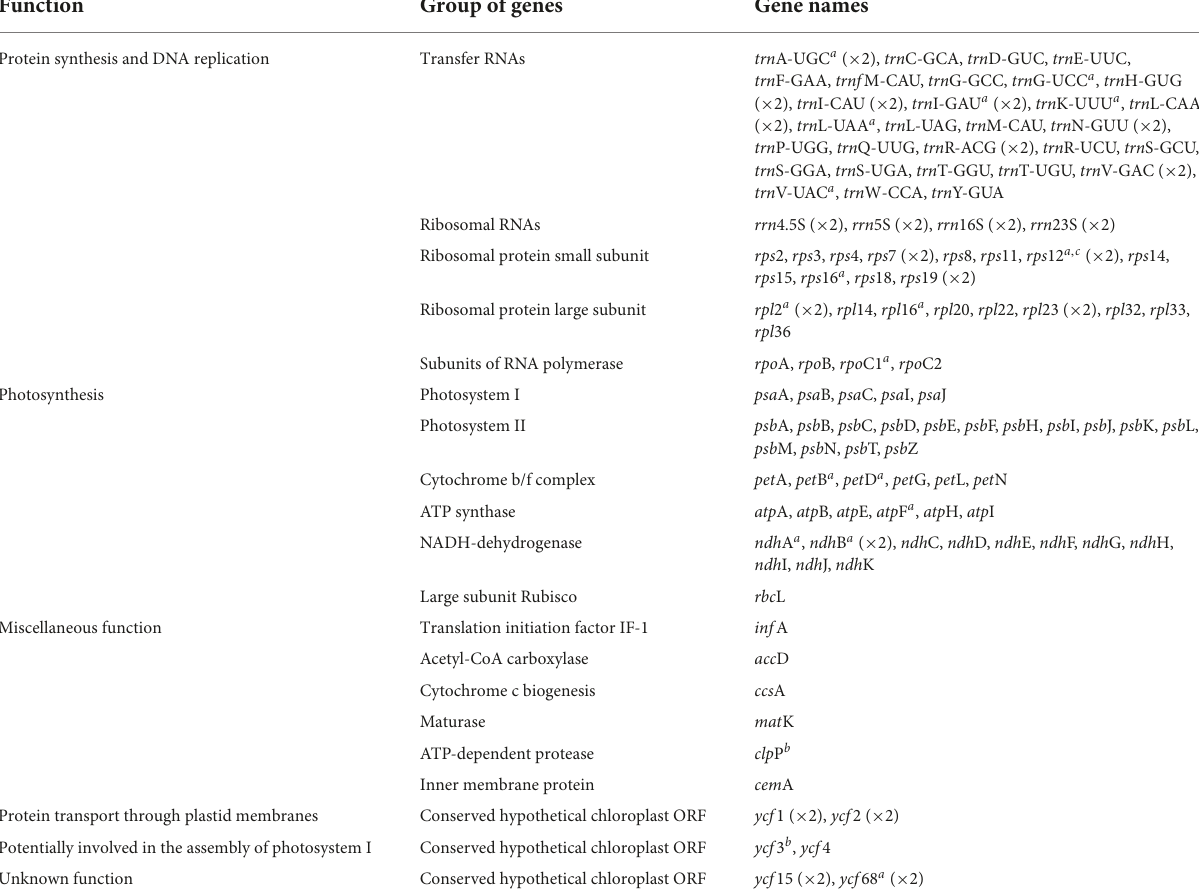
TABLE 2 Genes present in the plastome of species of core